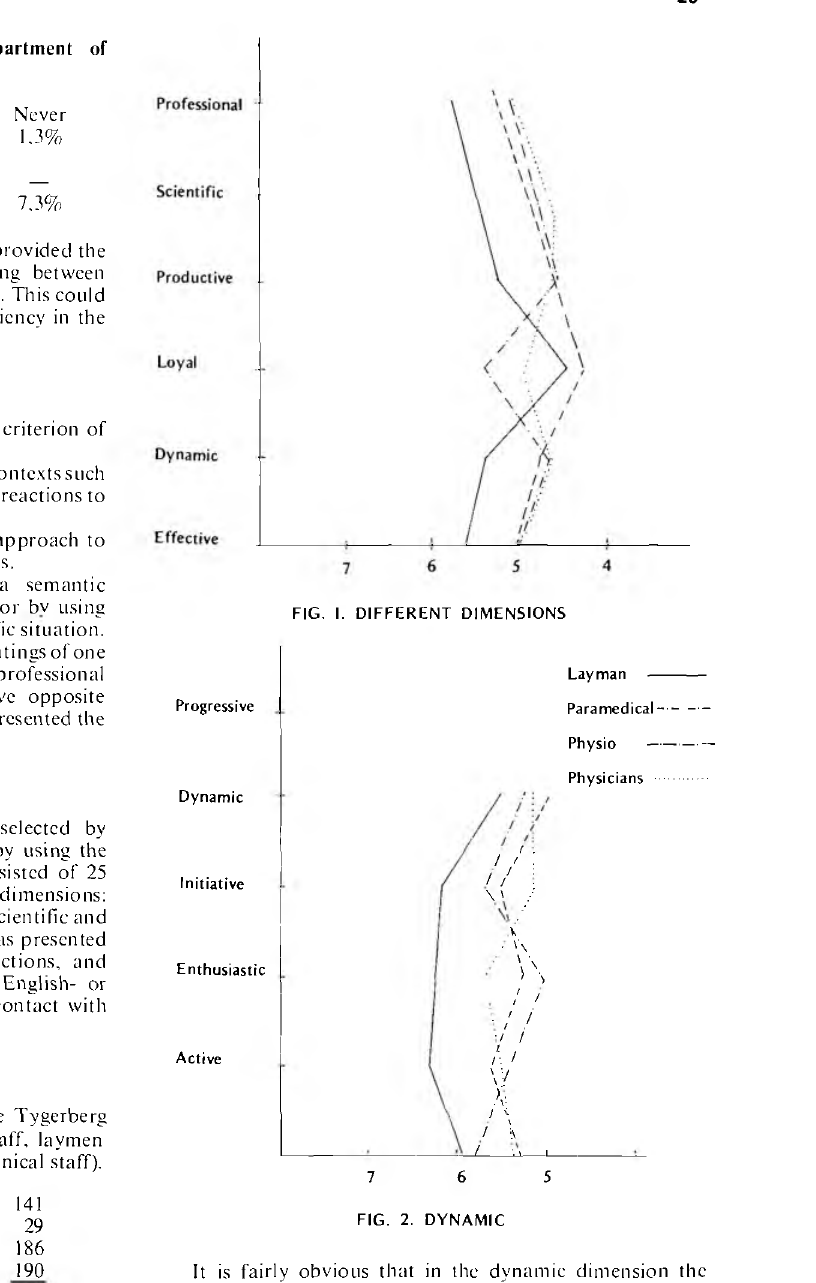
Table 1. Degree of contact with the Department of Physiotherapy Often Seldom Never 57.9% 41.5% 1.3% 66.4% 33.7% — 61.6%) 31.2%